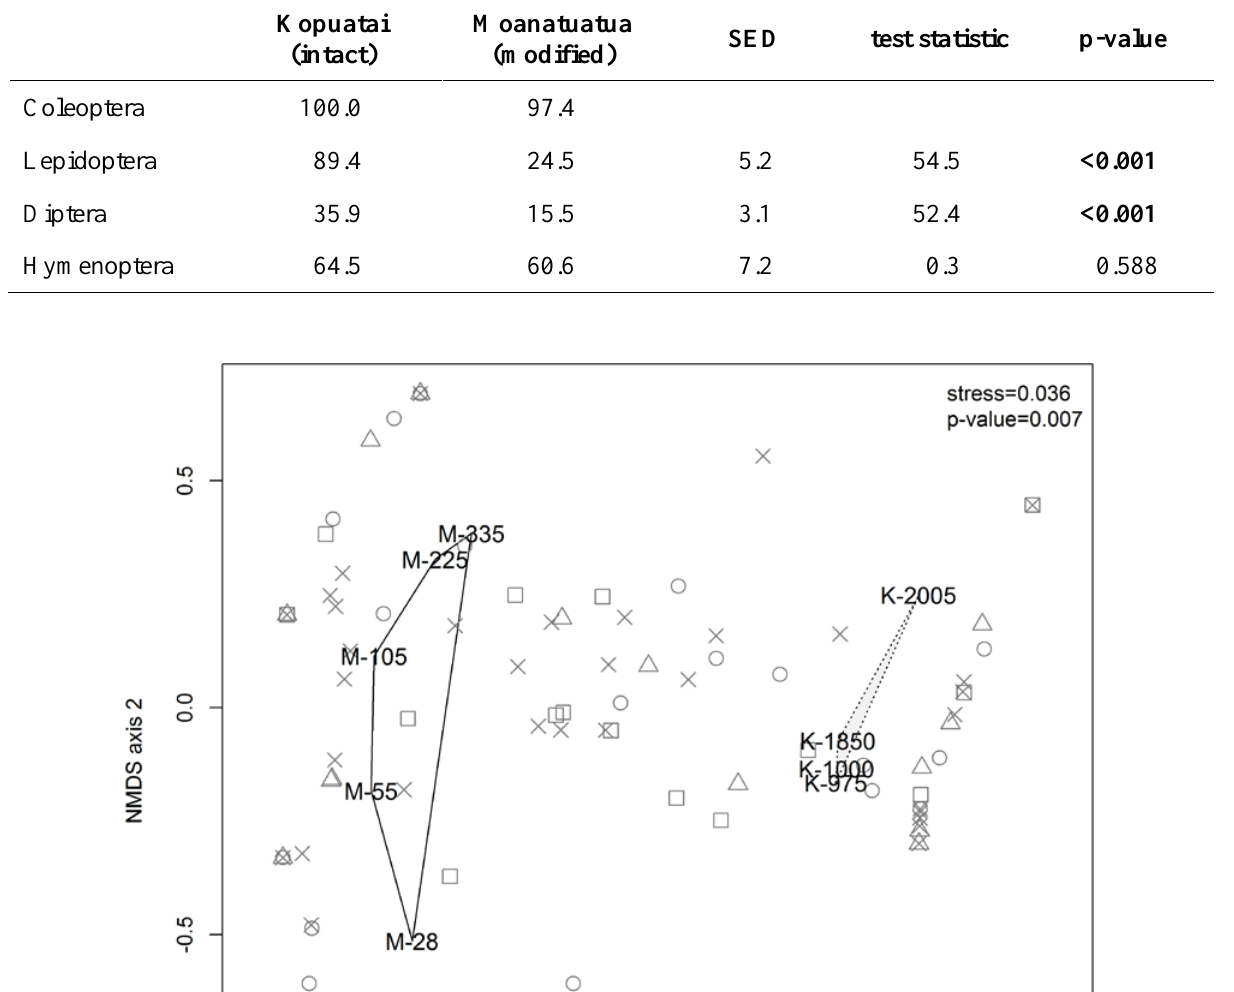
Table 2. Mean percentage of native species per plot sampled using Malaise traps at intact and modified raised peat bogs in New Zealand for the four most common Orders. For Lepidoptera, Diptera and Hymenoptera this includes Wald test statistics for differences between these sites (SED = standard error of the difference; df = degrees of freedom). These are not given for Coleoptera as nearly all Coleoptera caught were native. p-values ≤ 0.05 are in bold.